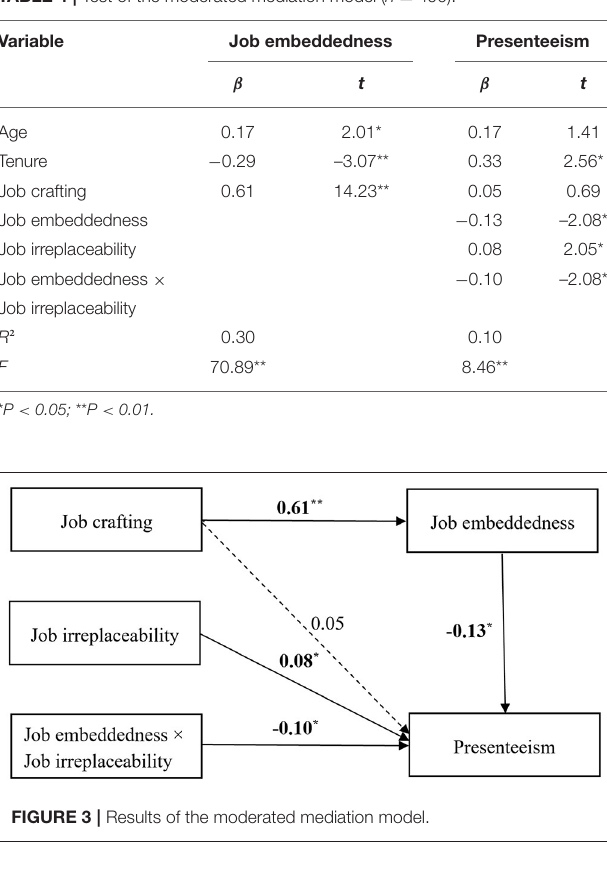
TABLE 4 | Test of the moderated mediation model ( n = 490).